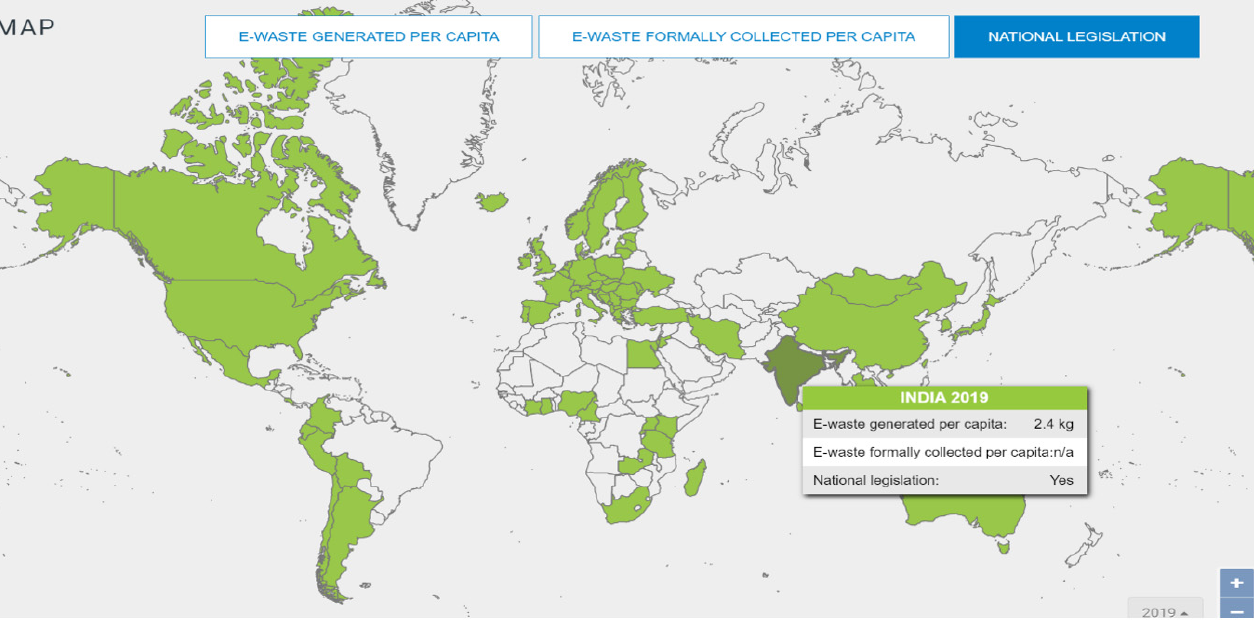
Figure 1. Global E-waste Statistics. Source: Global E-waste Statistics Partnership, 2019 [17].